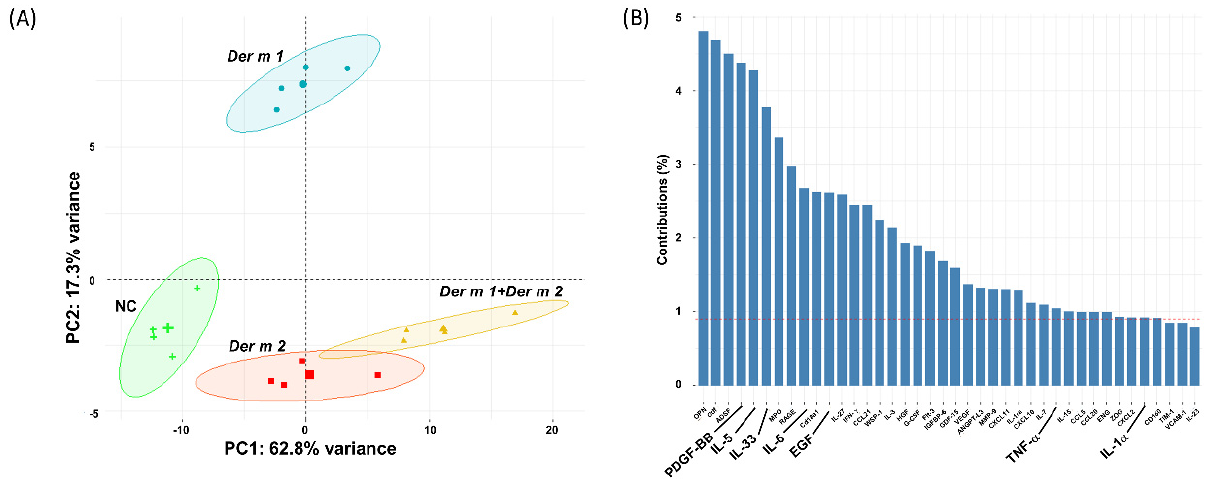
Figure 7. The principal component analysis (PCA) of mouse cytokines protein array profiles of the sensitized mice by different Der m major allergens. ( A ) The diagram showed the different groups of four sensitized mice by different allergens, including negative control (NC), Der m 1 , Der m 2 , and the combination of Der m 1 and Der m 2 ( Der m 1 + Der m 2 ). Each cytokine array contained 111 mouse cytokines (R&D SYSTEMS #ARY028). ( B ) The bar chart showed the principle components in dimension 2 of the PCA results, which is the major difference between Der m 1 and Der m 2 . 2.5. Der m 1 Is a Cysteine Proteinase That Digested the α Chain of Fibrinogen, and the Combination of Fibrinogen Cleavage Products Could Induce the Expression of Pro-Inflammatory Cytokines The fungal protease or allergen source-derived protease can cleave native fibrinogen into FCPs, which can engage the TLR4 receptor in allergic airway disease [12,13,24]. Re- garding the mechanism of Der m 2 alone and the combination of Der m 1 + Der m 2 , we hypothesized that FCPs may play an important role in the synergistic effect of Der m 1 + Der m 2 . Firstly, recombinant Der m 1 was found to cleave the native fibrinogen in vitro and could partially degrade 5.4% to 37.1% of the native fibrinogen α chain under 6–24 h of processing (Figure 8). FCPs were generated in vitro ( Der m 1 -derived FCPs) from the native fibrinogen through Der m 1 proteolytic digestion. An epithelial cell line from the human bronchial epithelium, BEAS-2B cells, was used to treat FCPs. The mRNA expression levels of the pro-inflammatory cytokines IL-6 ( p < 0.001) and IL-8 ( p < 0.01) were elevated by Der m 2 alone, Der m 1 -derived FCPs, or a combination of them both, but not by the native fibrin- ogen alone or Der m 1 -derived FCPs alone (Figure 9). Furthermore, the combination of Der m 1 -derived FCPs and Der m 2 significantly increased the mRNA expression levels of IL- 6 and IL-8 by two- and threefold than those of Der m 2 alone and Der m 2 combined with native fibrinogen, respectively ( p < 0.001, Figure 9). These results indicate that the combi- nation of Der m 2 and Der m 1 derived-FCPs synergistically trigger the gene expression of pro-inflammatory cytokines IL-6 and IL-8.